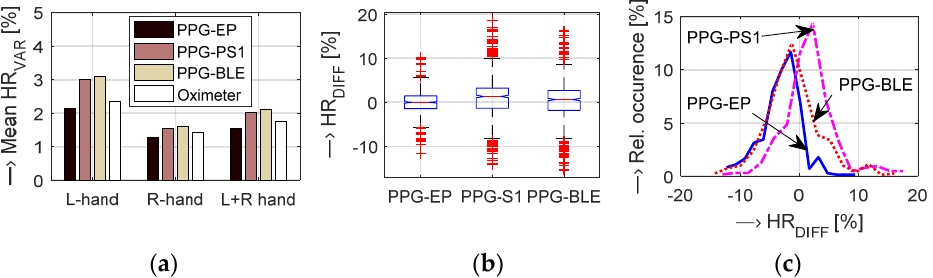
Figure 12. Statistical results of comparative measurements by the oximeter device for all three tested PPG sensor prototypes: ( a ) bar-graph of mean variances of HR values separately for both hands, ( b ) boxplot of basic statistical parameters of HR DIFF values joint for both hands, ( c ) histograms of HR DIFF values for left and right hands together; all tested persons. Table 4. Mean HR stability parameters calculated from the PPG signal measured in parallel by the BPM device for all tested persons.